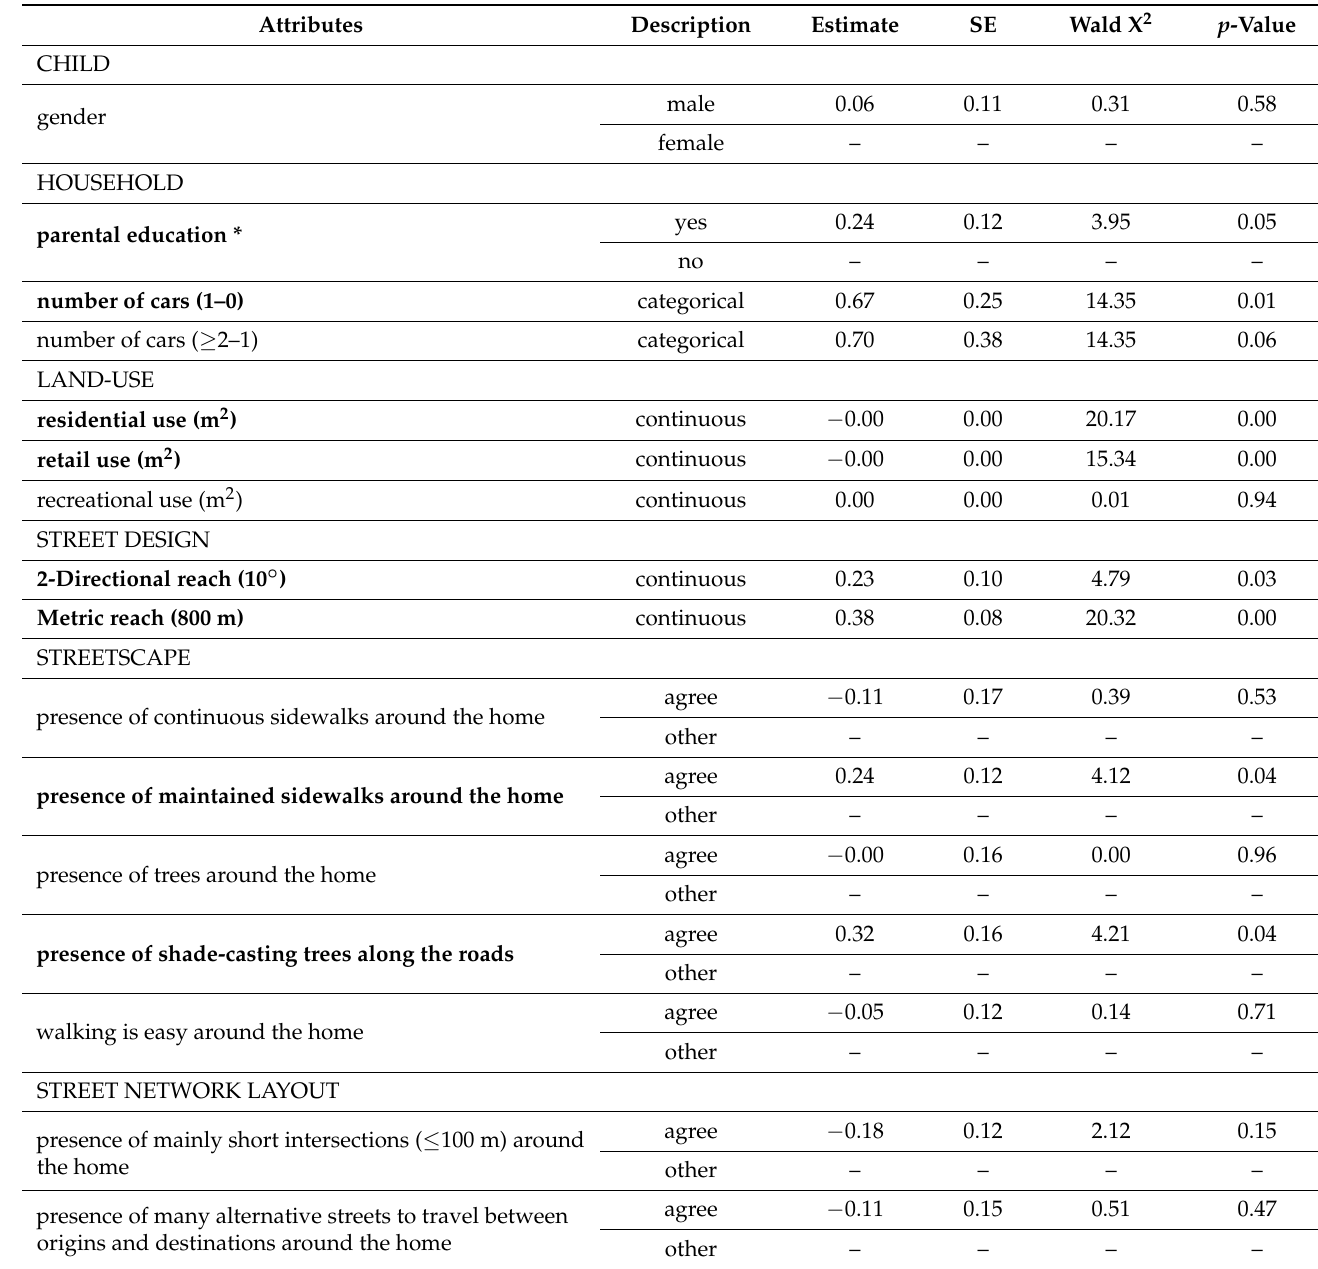
Table 4. Attributes associated with children’s walk mode choice (either way), for children living within 1600 m of their schools. n =